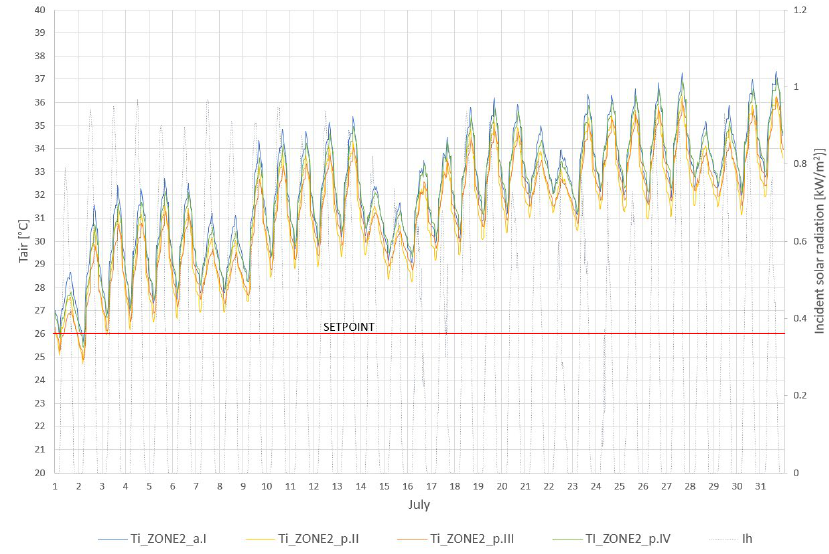
Figure 14. Effects of glazing system on mean indoor air temperature; summer period: July (floor 2).